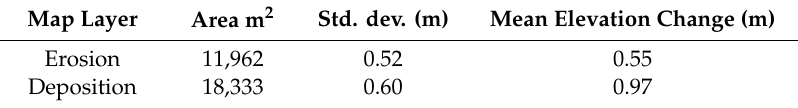
Table 1. Comparison of pixels classified as erosion area and deposition areas.